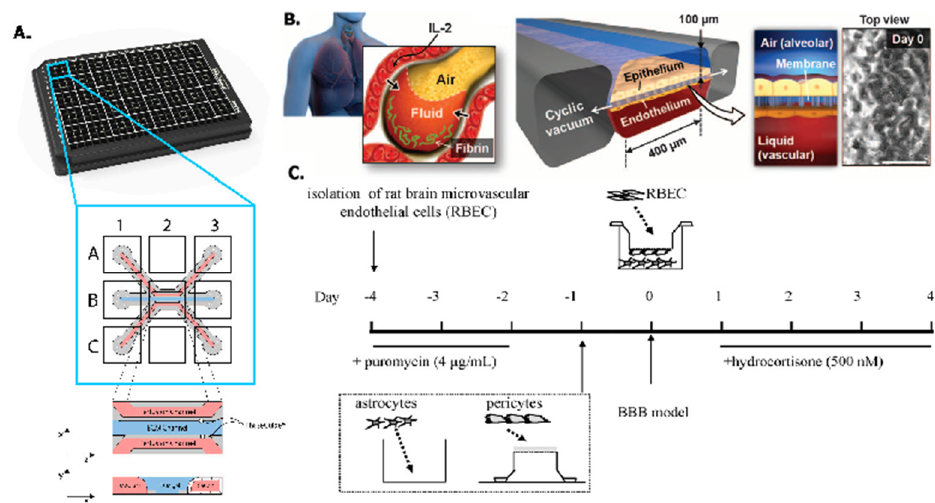
Figure 5. Some other-organ-on-a-chip systems for drug toxicity testing. ( A ) Schematic